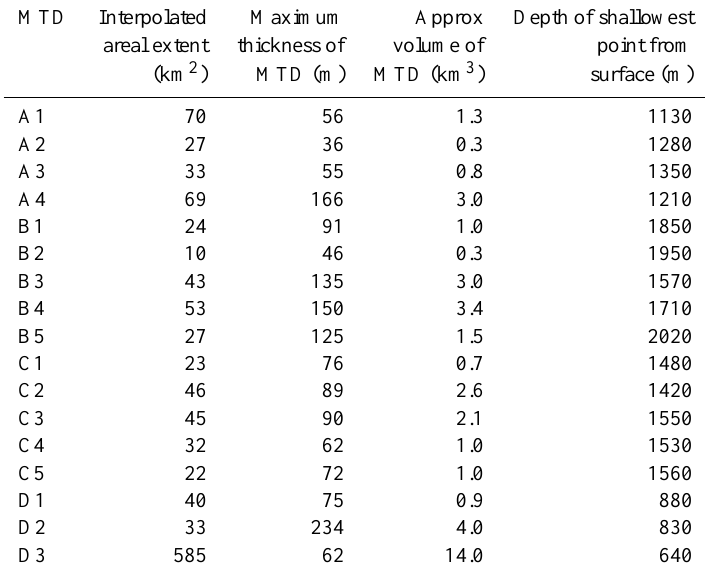
Table 1. Measured properties of identified MTDs in the working area. MTD Interpolated Maximum Approx Depth of shallowest areal extent thickness of volume of point from (km 2 ) MTD (m) MTD (km 3 ) surface